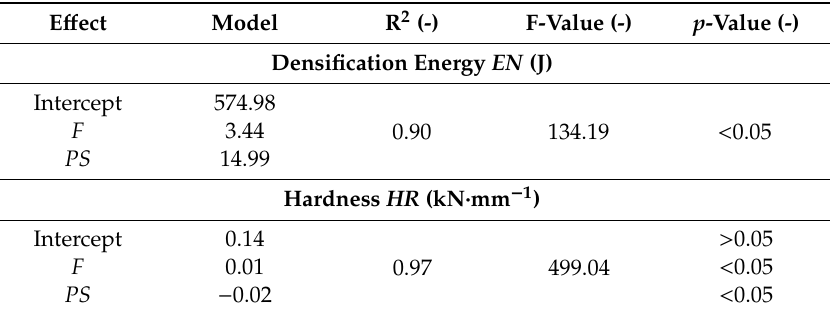
Table 5. Regression results of energy and hardness of ground sunflower stalk briquettes with the e ff ects of force and particle size.